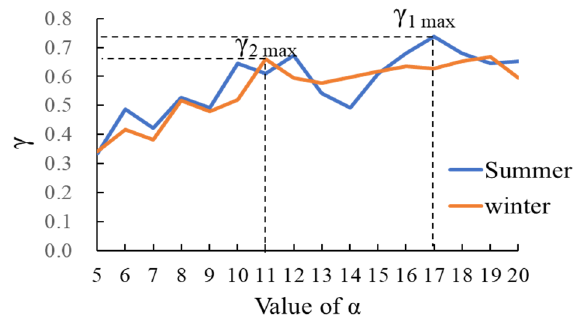
Figure 12. Optimal solutions under different values of α .